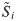
Excitability (Eq 1) for patient J.The color scale quantifies the epileptogenic activity, S˜i, for each electrode, i (y-axis). The x-axis marks the time relative to seizure onset (as determined by an expert neurophysiologist).